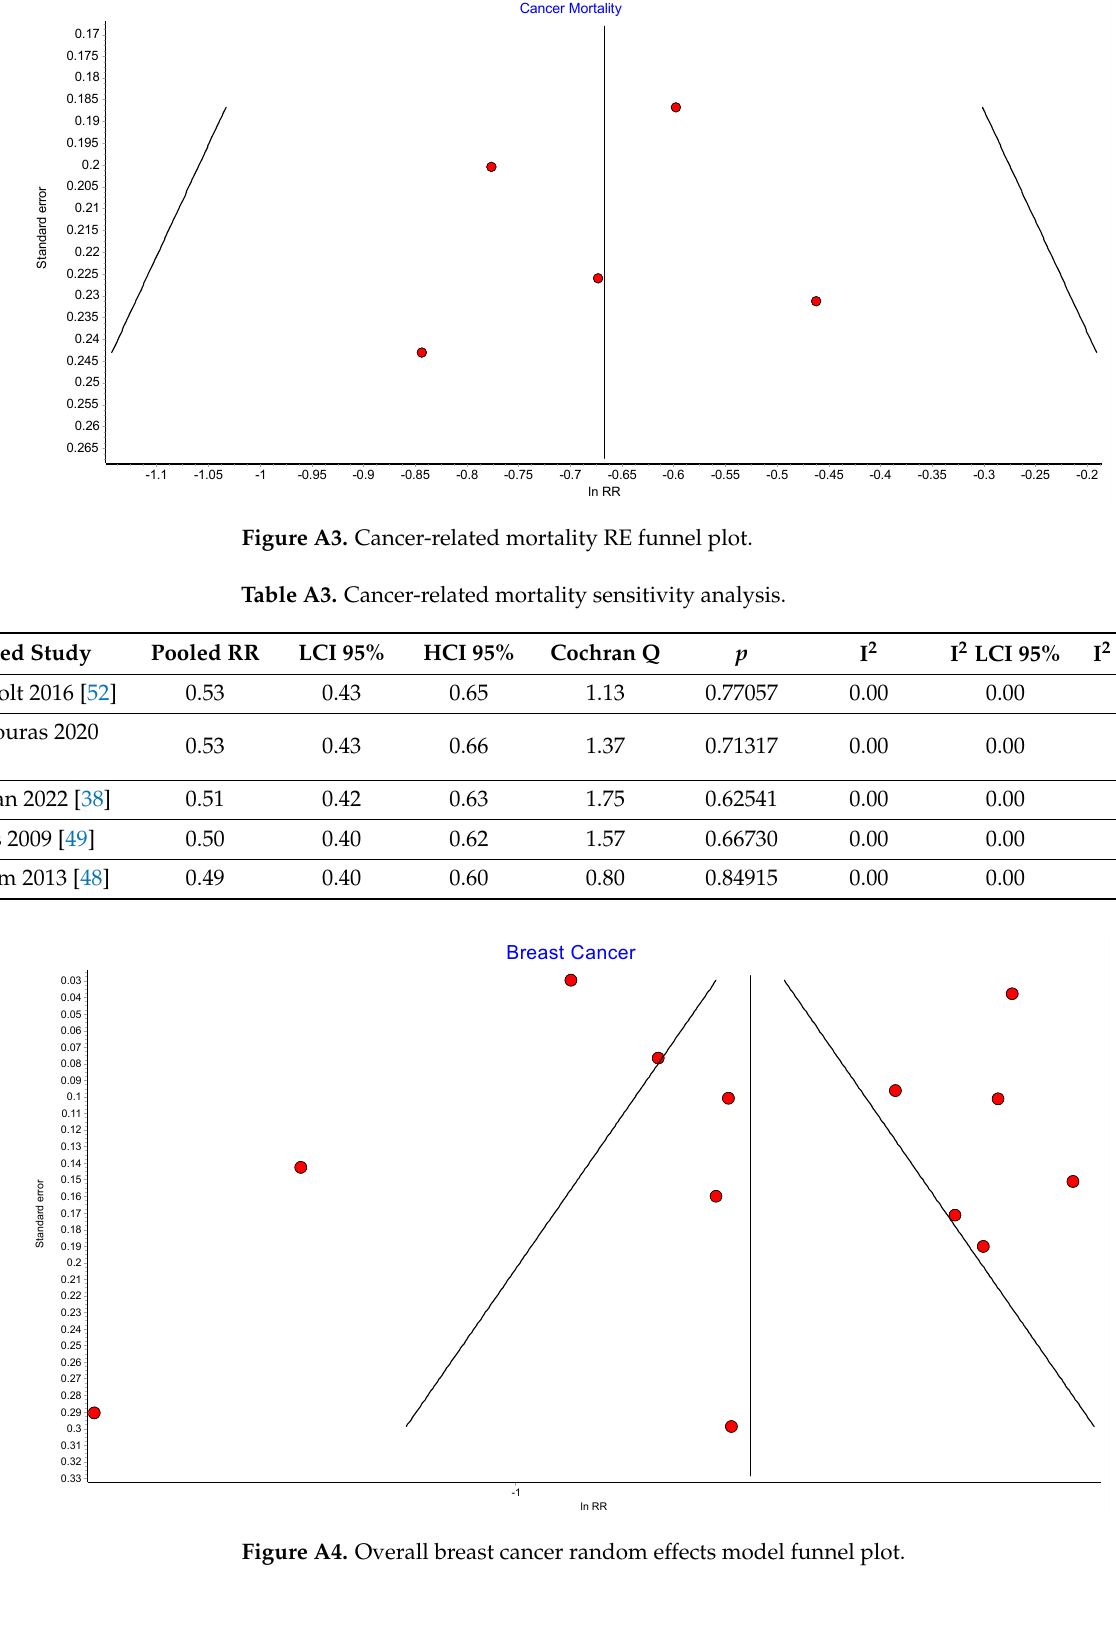
Table A4. Overall breast cancer random e ff ects model sensitivity analysis.